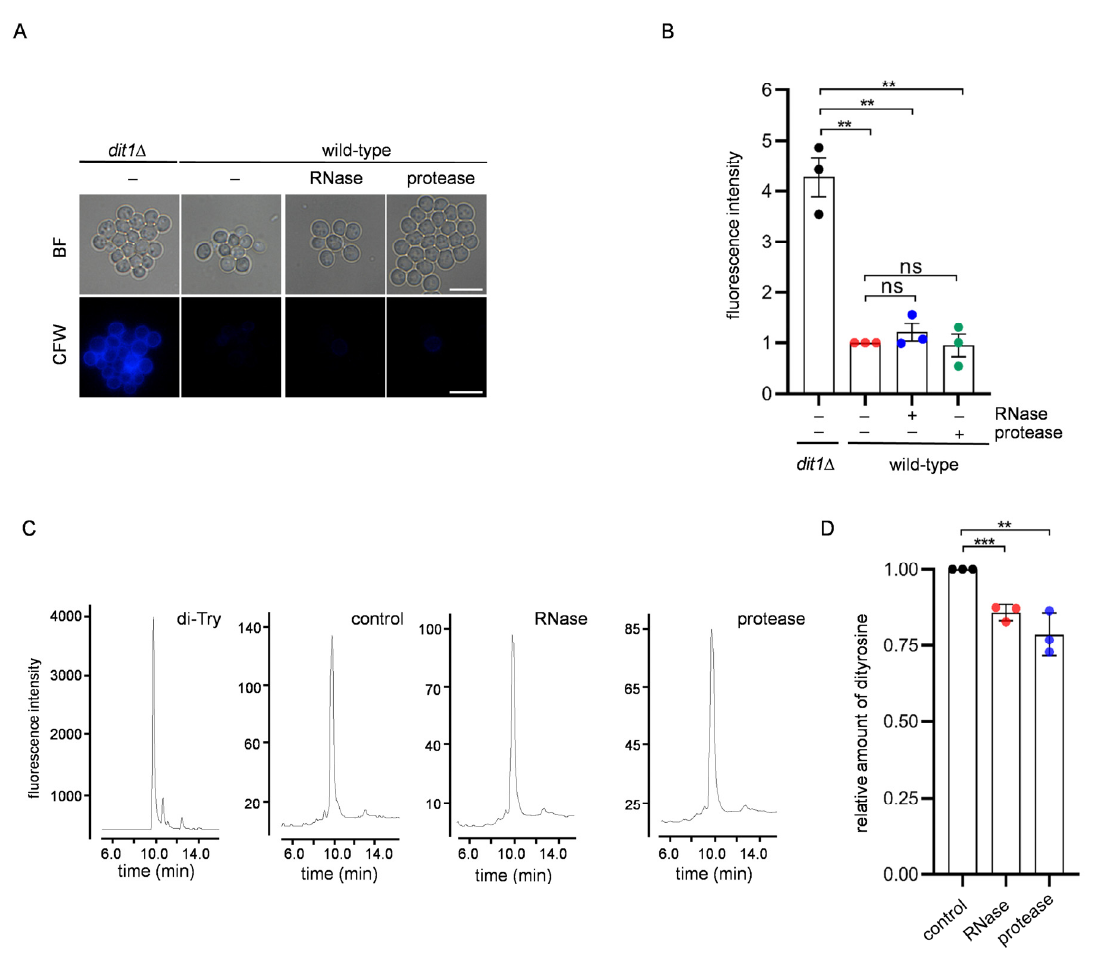
Figure 2. Detection of dityrosine in spores after RNase or protease treatment. ( A ) dit1 ∆ and wild- type spores treated with or without ( − ) RNase or protease were stained with CFW and observed under fluorescence (CFW) or bright field (BF) microscopy. Scale bar, 5 μ m. ( B ) Quantification of the fluorescence intensities of CFW of cells described in ( A ). ( C ) Spores treated with or without (control) RNase or protease were hydrolyzed with 6 N HCl, and the lysates were subjected to HPLC analysis. Representative chromatograms are shown. Synthesized dityrosine (di-Tyr) was assayed as a control. ( D ) The relative amount of dityrosine detected by HPLC is described in ( C ). The dityrosine peak detected in the control sample was defined as 1. Data are presented as the mean ± SEM. Statistical significance was determined by two-tailed unpaired Student’s t -tests. n = 3. **, p < 0.01; ***, p < 0.001; ns, not significant ( p ≥ 0.05).